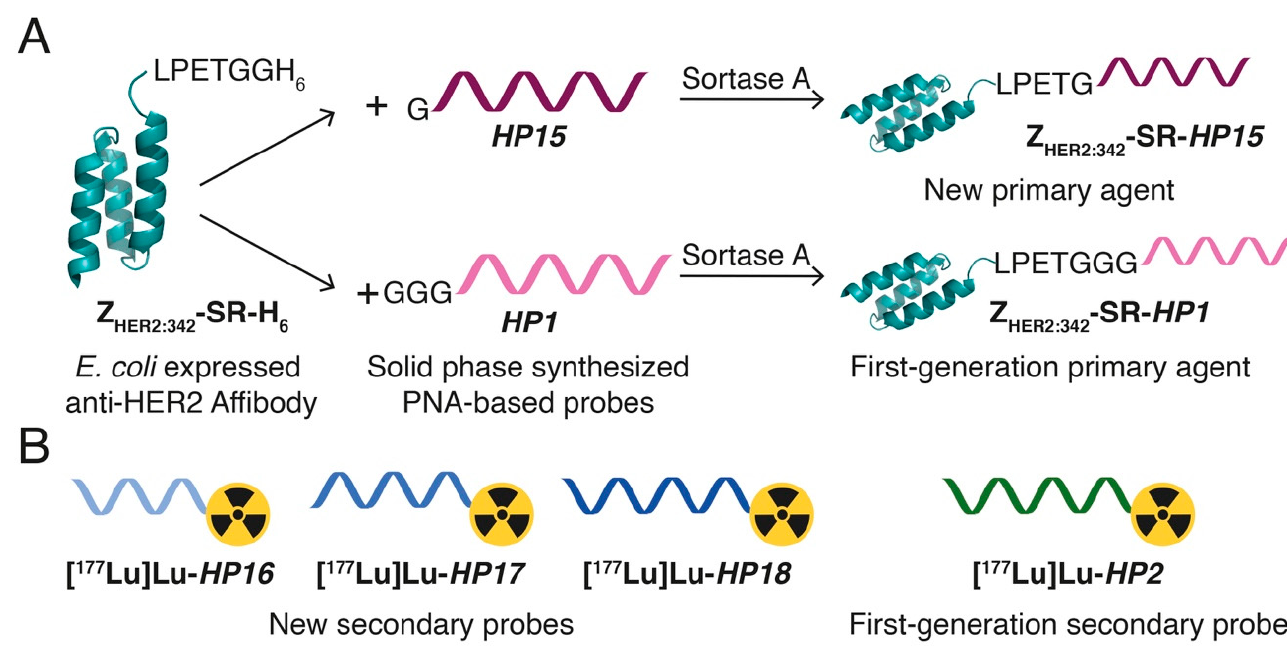
Figure 1. Schematic illustration of the ( A ) primary agents and ( B ) secondary probes used in this study (for PNA probe sequences, see Table 1). ( A ) The new primary agent, Z HER2:342- SR- HP15 , was produced using sortase-catalyzed ligation of a solid phase-synthesized PNA-based probe, HP15 , to an E. coli -expressed anti-HER2 affibody molecule, Z HER2:342 -SR-H 6 . The resulting chimeric Z HER2:342- SR- HP15 was designed to have the ability to simultaneously bind to HER2-overexpressing tumor cells and to one of the new complementary secondary probes, HP16 , HP17 , or HP18 , with high affinity. For comparative biodistribution studies, the first-generation primary agent Z HER2:342- SR- HP1 was produced using the same protocol for Z HER2:342- SR- HP15 . Z HER2:342- SR- HP15 and Z HER2:342- SR- HP1 contain the same affibody molecule and differ only in the sequence of the attached PNA-based probe. ( B ) The three new secondary probes, HP16 (9-mer PNA), HP17 (12-mer PNA), and HP18 (15-mer PNA), were designed to bind to Z HER2:342- SR- HP15 (15-mer PNA) through sequence-specific PNA:PNA hybridization. The new secondary probes were synthesized using solid phase synthesis, and all carry a DOTA chelator for radiometal labeling with, in this study, 177 Lu. For biodistribution studies in vivo, the first-generation secondary probe HP2 was produced and 177 Lu-labeled using the same protocols for the new secondary probes.